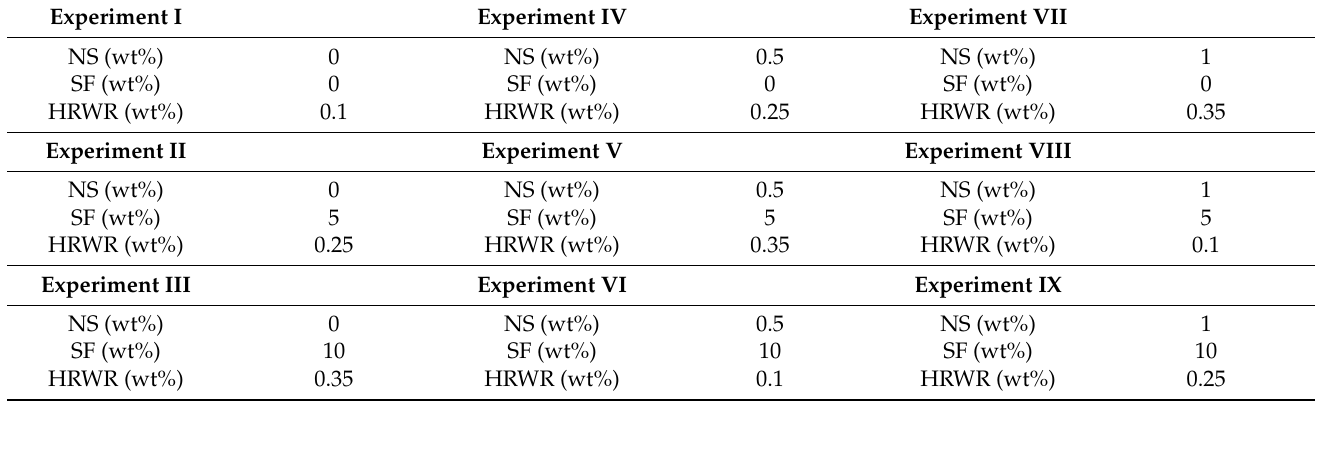
Table 6. Experimental grout mix design.